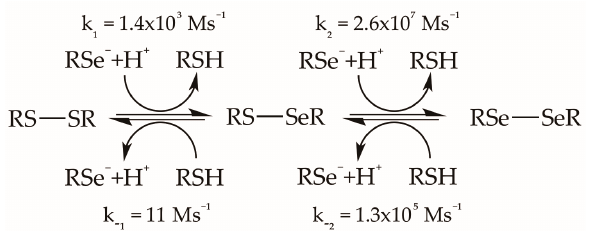
Table 1. General properties of sulfur and